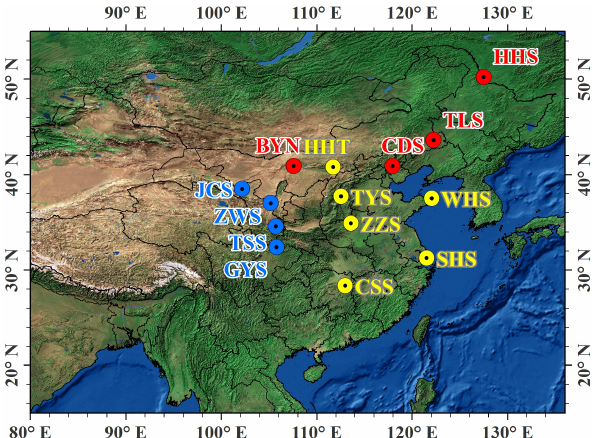
Figure 9. The locations of the 14 air quality stations. Different colours represent different dust transport directions denoted by se- quencing site names in chronological order of when the dust passes: the north-east direction of BYN–CDS–TLS–HHS, and the two south directions of JCS–ZWS–TSS–GYS and HHT–TYS–ZZS– CSS. Note the east direction travelling to the Sea of Japan is not shown as most of its path is over the sea without air quality